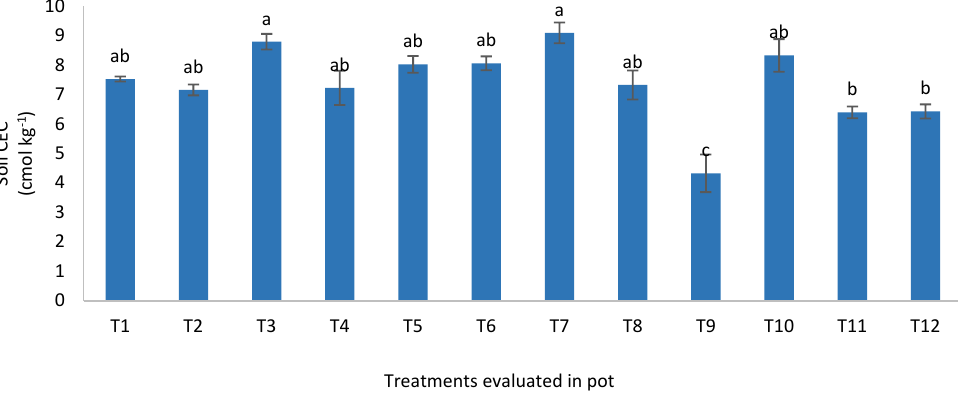
Figure 15. Effects of treatments on soil exchangeable Fe 2+ . Different letters indicate significant difference between means using Tukey’s HSD (Honestly Significant Difference) test at p ≤ 0.05. The error bars are the ± standard error of triplicates.